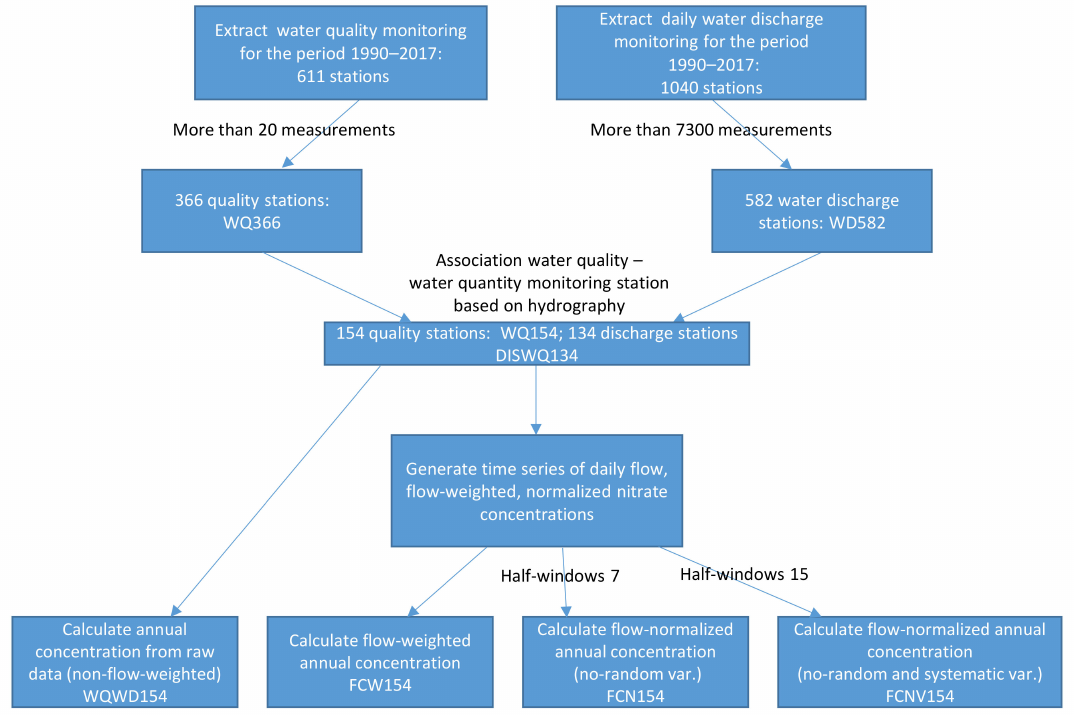
Figure 2. Flow chart of the generation of the various time series of nitrate